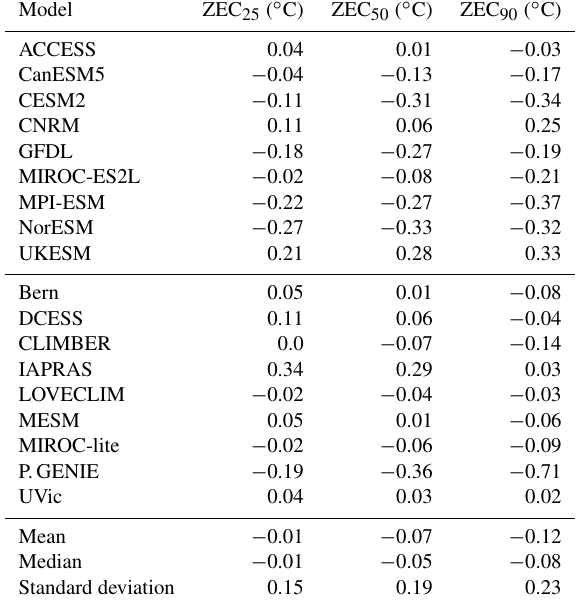
Table 5. Temperature anomaly relative to the year that emissions ceased, averaged over a 20-year time window centred on the 25th, 50th, and 90th year following cessation of anthropogenic CO 2 emis- sions (ZEC 25 , ZEC 50 , and ZEC 90 , respectively) for the A1 (1% to 1000PgC